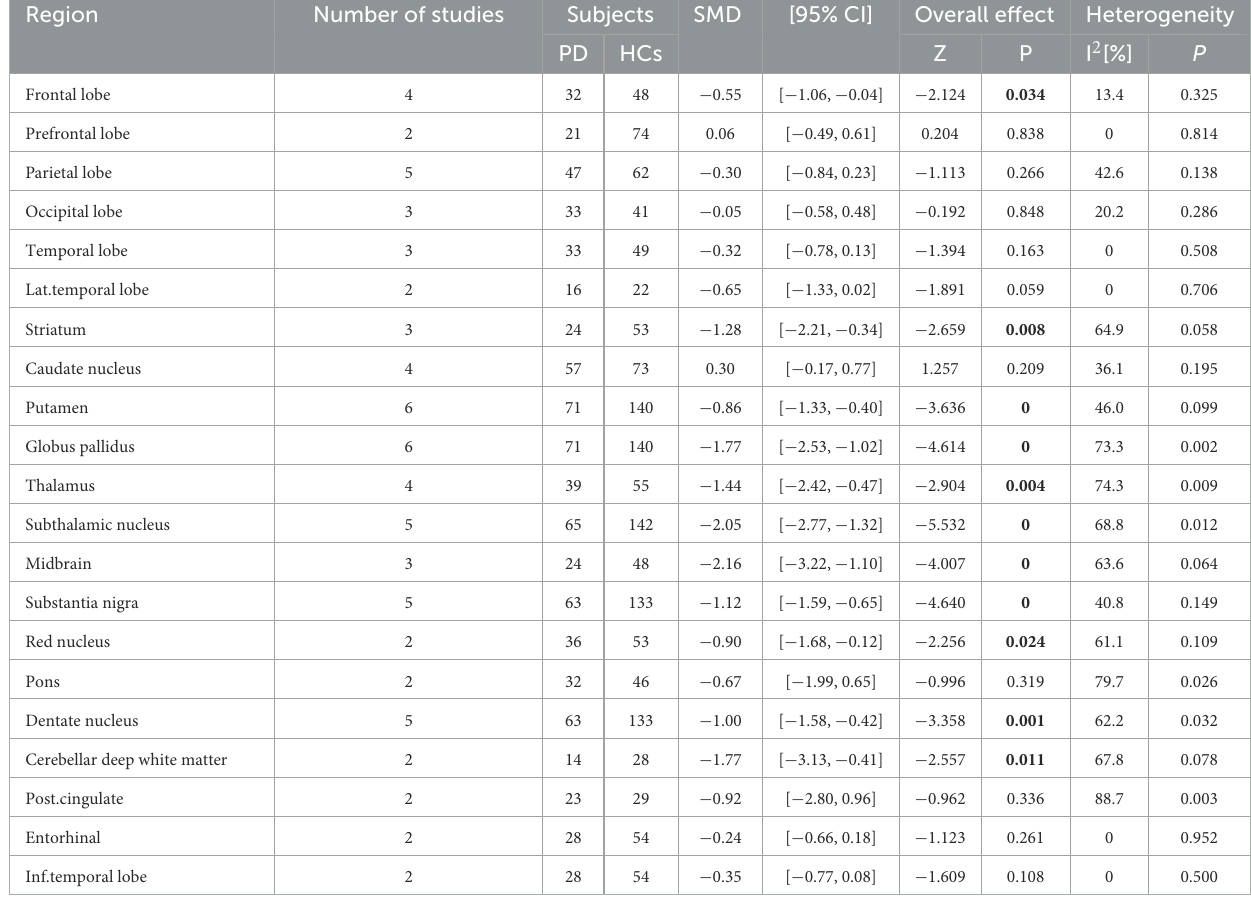
TABLE 6 Random effects meta-analyses results between PD and PSP subjects. Region Number of